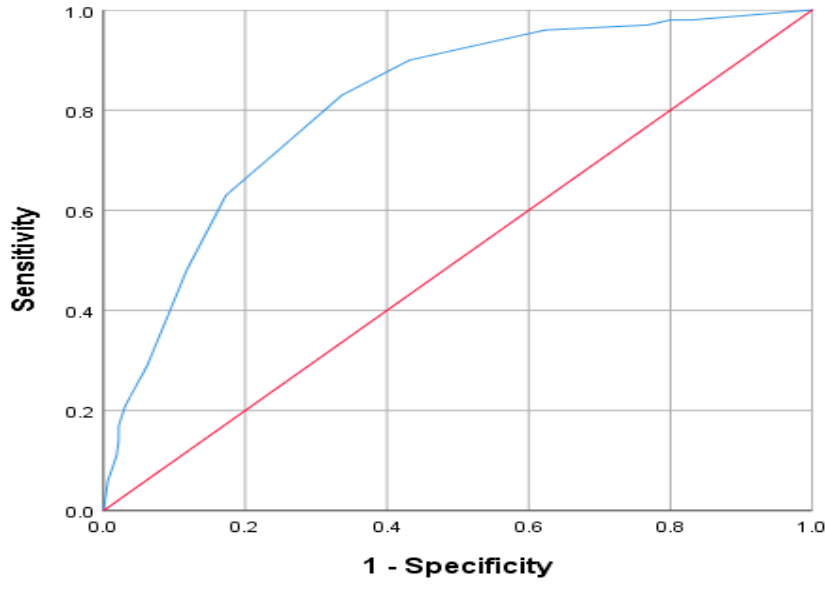
Figure 3. Receiver Operator Curve (ROC)-presenting the relationship between sensitivity and specificity of CIDT-MD for every possible cutoff. (Blue curve = ROC curve, Red Line = chance line).